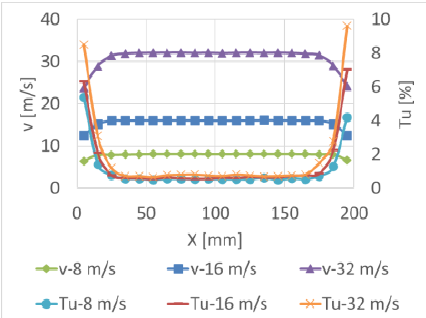
Fig. 1. Profiles of velocity and turbulent intensity in the wind tunnel test section